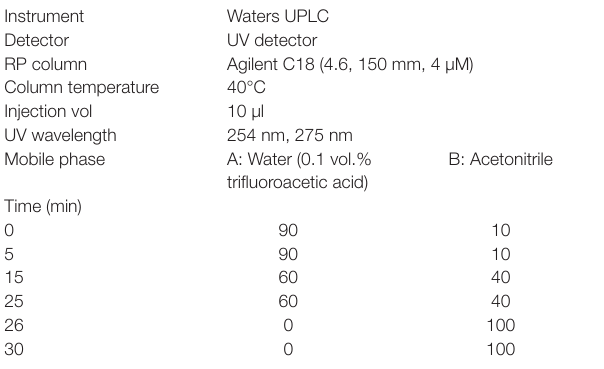
TABLE 2 | Ultra performance liquid chromatography (UPLC) conditions of